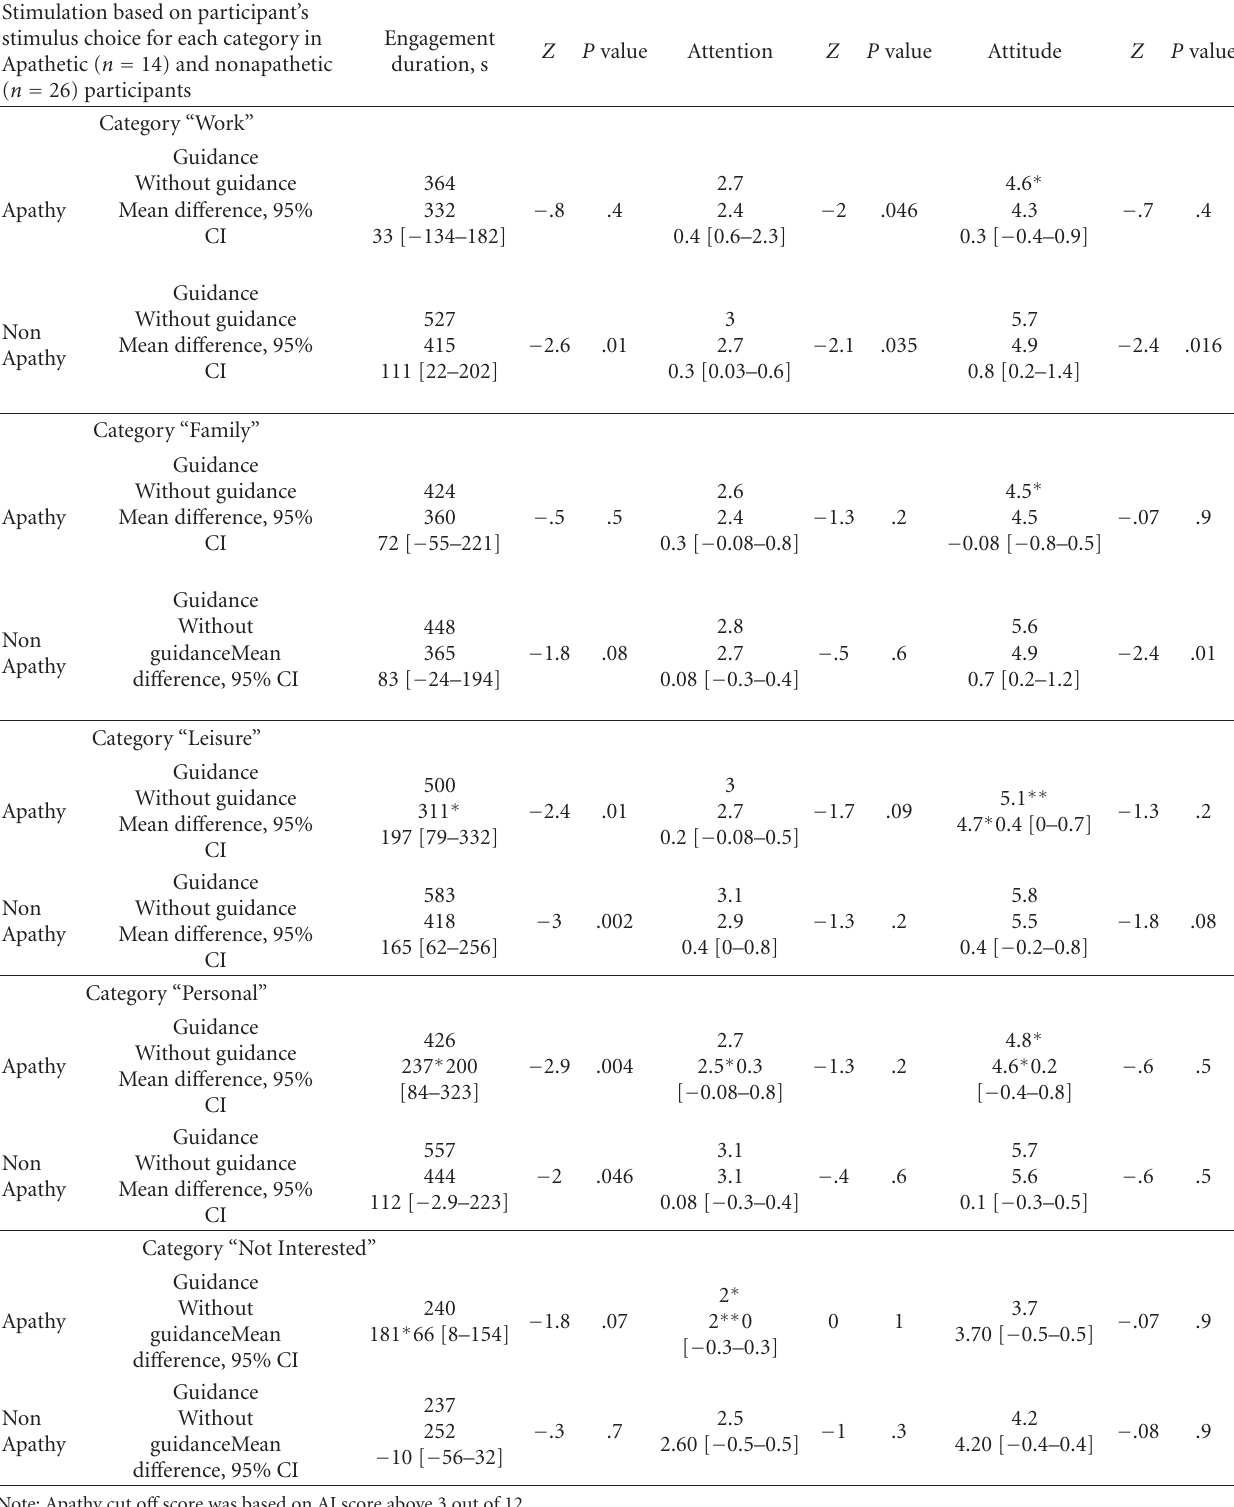
Table 4: Observational Measurement of Engagement (OME) scores in guided and unguided conditions in apathetic and non apathetic